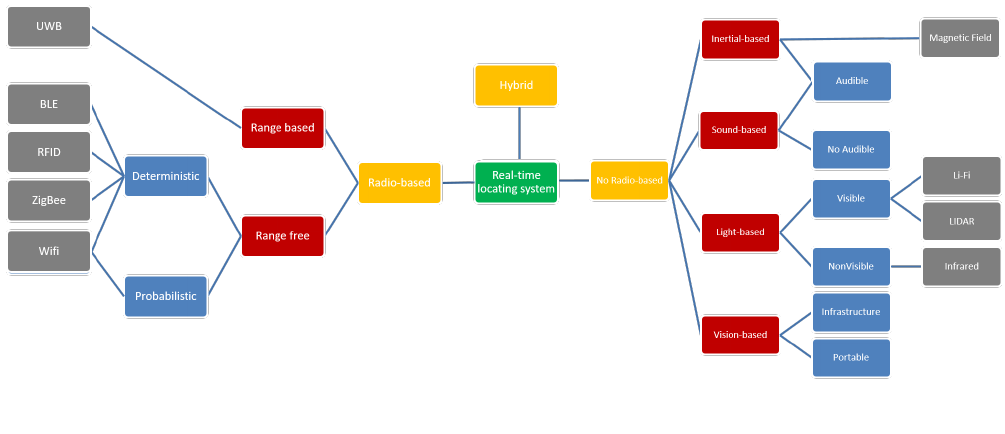
Figure 3. Classification of RTLS